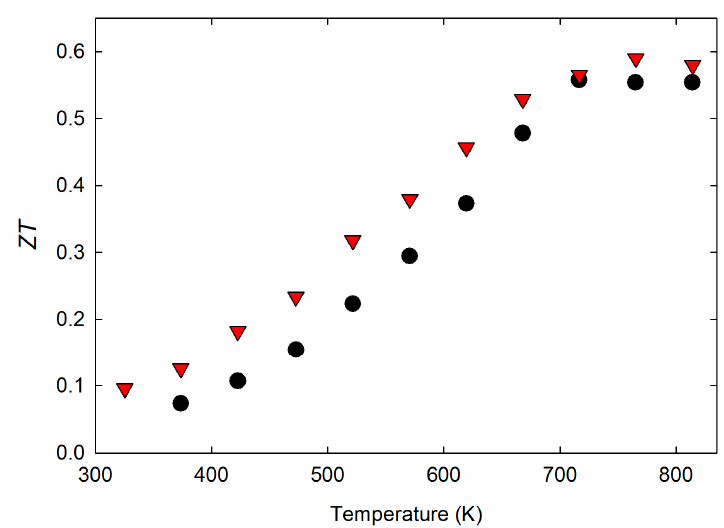
Figure 4. Temperature-dependent ZT for Yb 0.13 In 0.02 Co 3 FeSb 12 (circle) and Yb 0.39 In 0.02 Co 2.4 Fe 1.6 Sb 12 (triangle).